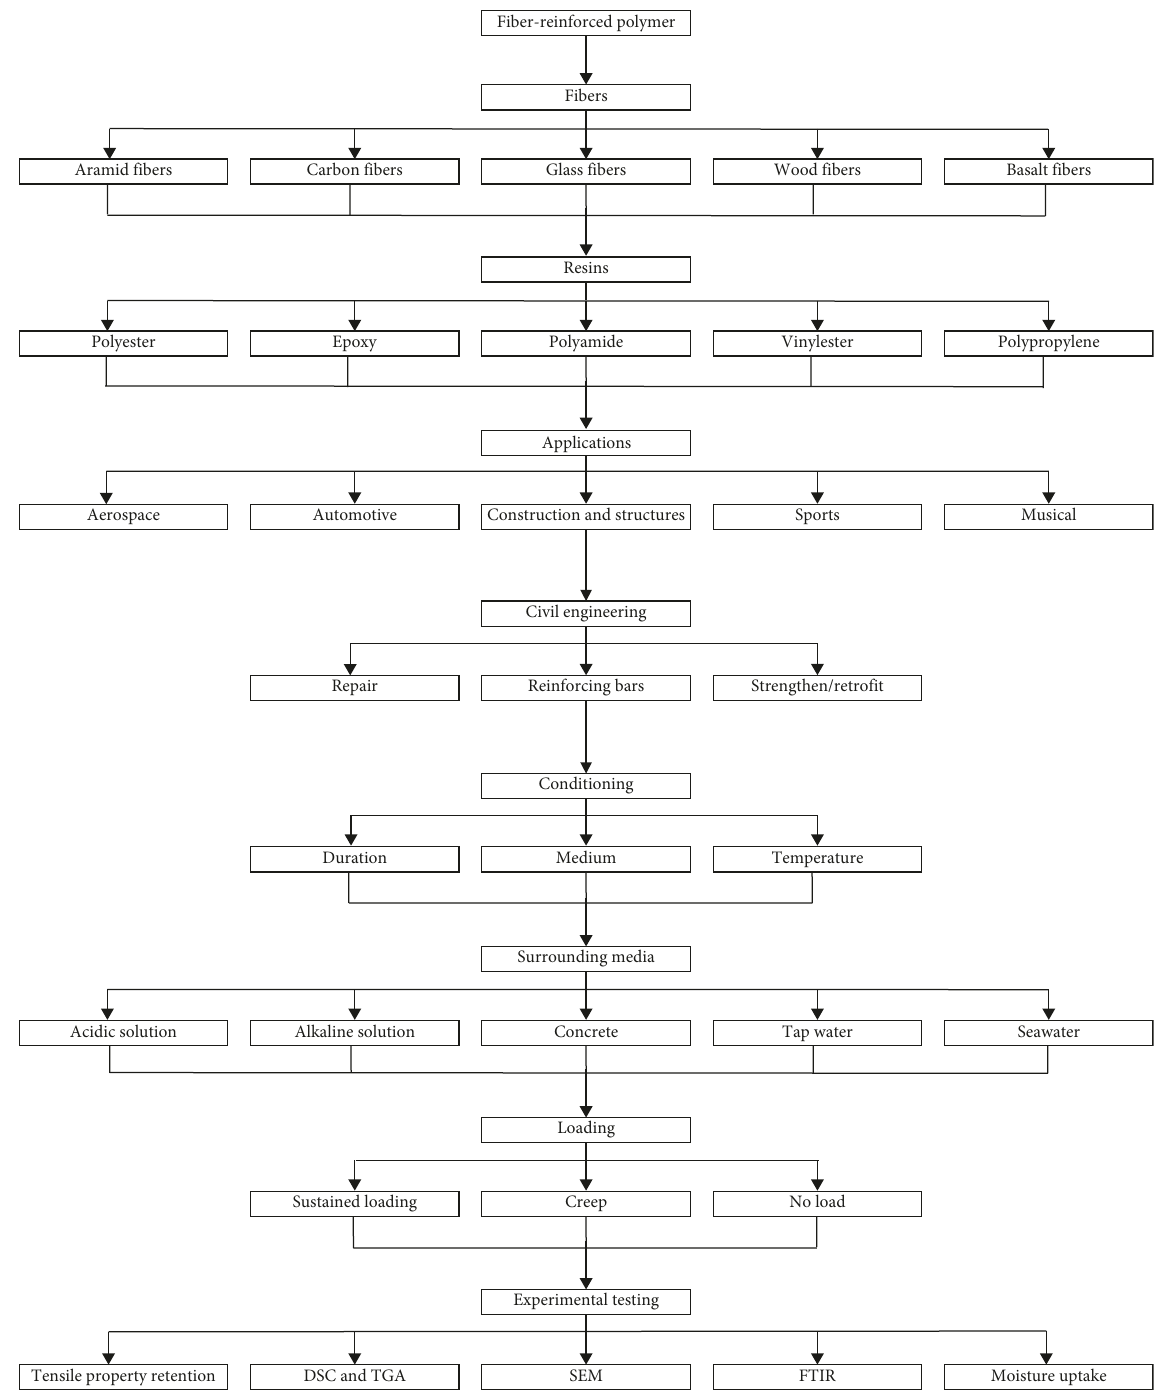
Figure 1: Taxonomy on the studies of fiber reinforced polymer